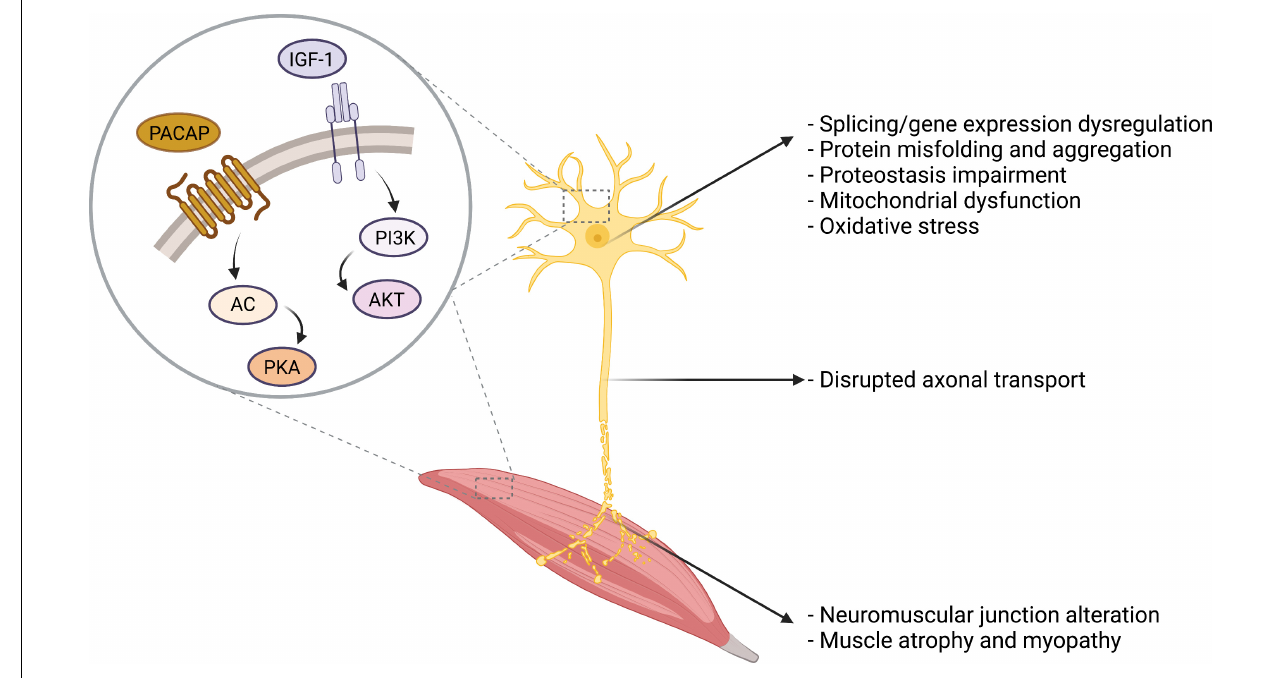
FIGURE 2 | Overview of the cellular and molecular alterations in MNDs. Several cellular and molecular alterations are common to distinct MNDs, including protein misfolding and aggregates, proteostasis impairment, oxidative stress, and mitochondrial dysfunction. IGF-1 and PACAP main signal transduction pathways are presented in the